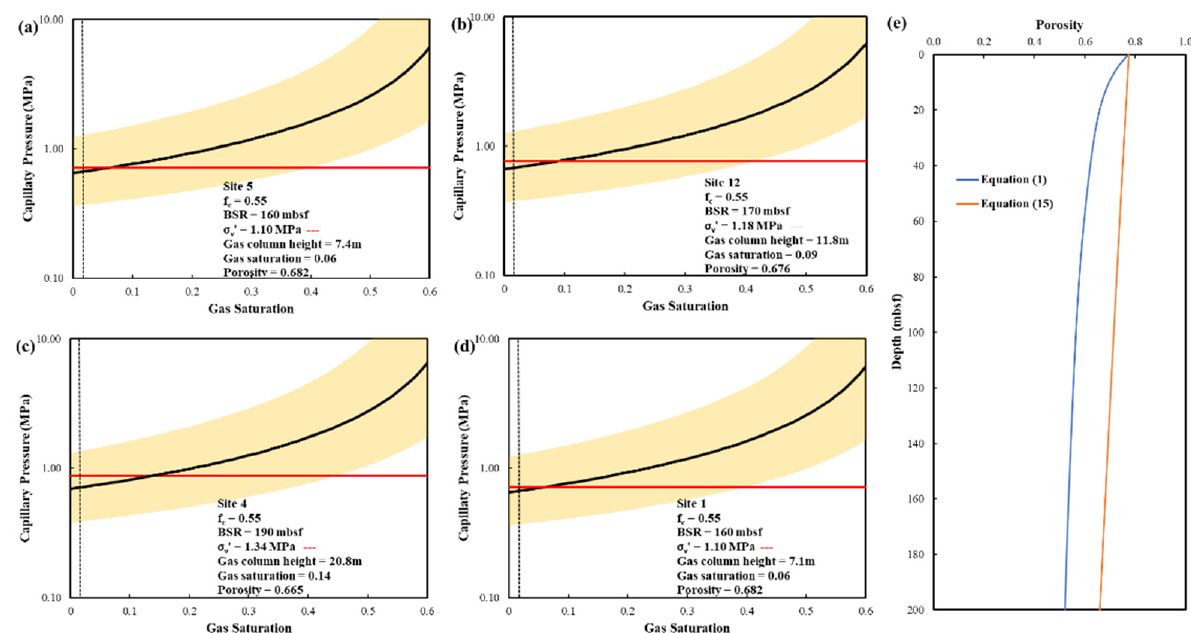
Figure 10. Capillary curves calculated using Equation (7) and porosity from Equation (15) for the 4 Sites. The sites are shown from west to east. Site 5 ( a ) is the westernmost, followed by Site 12 ( b ), Site 4 ( c ) and Site 1 ( d ). The black curve is the median capillary pressure, and the shaded region is the uncertainty ( ± 1 SD). The red line is the fracture criterion calculated using Equation (5) with porosity from Equation (15). The black dotted line is the gas mobility threshold. The minimum gas saturation required (median prediction) to open fractures and the gas column height (median prediction) are higher than the values predicted in Figure 5 with porosity estimated from Equation (1). ( e ) The porosity prediction from Equation (1) and Equation (15) as a function of depth is shown here.